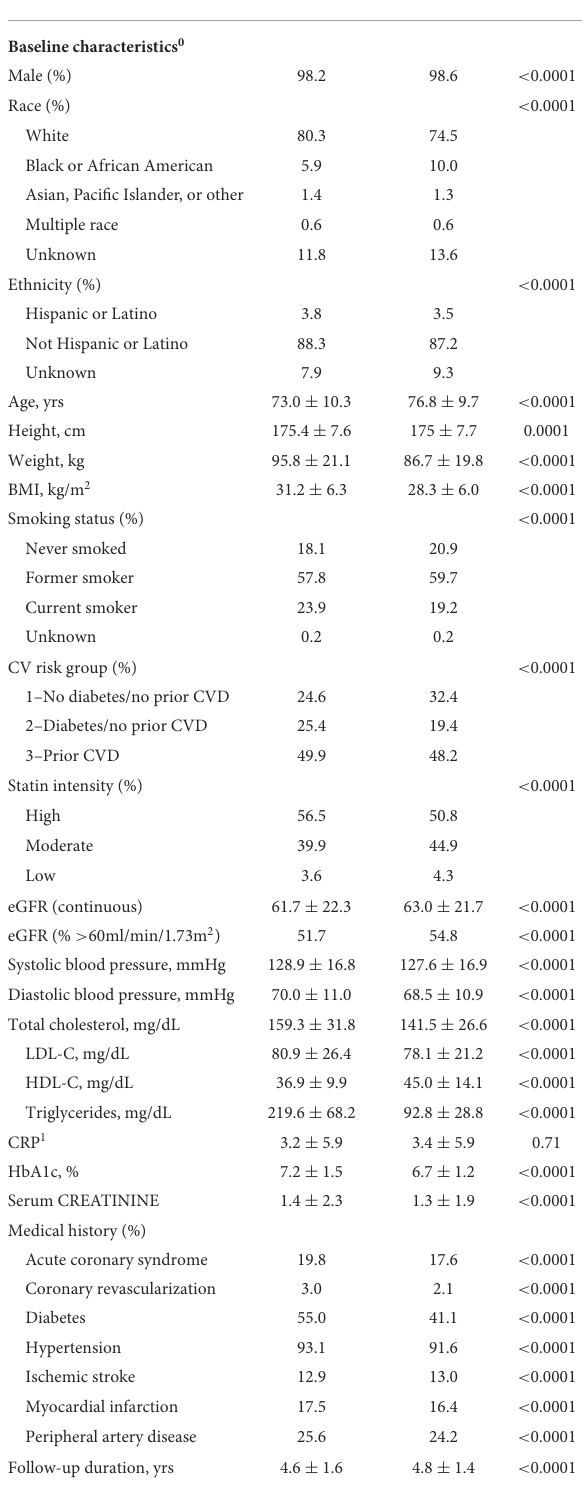
TABLE 2 Demographic and baseline